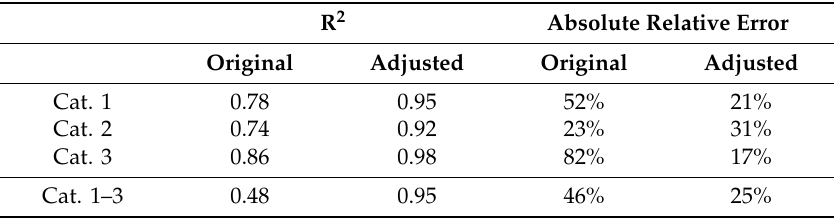
Table 6. Calibration results for groundwater nitrogen retention